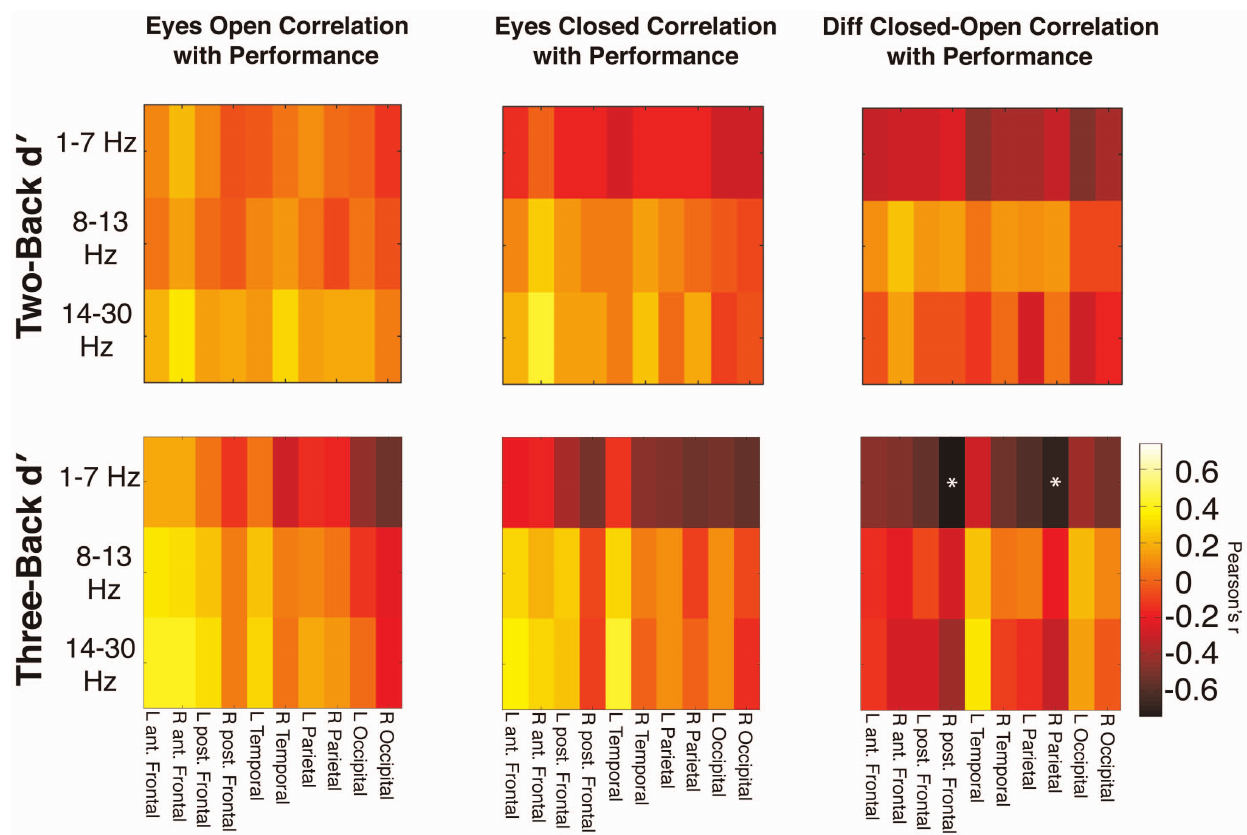
Figure 4. Pearson correlation coefficient (r) values between both two-back and three-back performance and normalized power in each region and band. The normalized difference between eyes closed and open power (zECO) revealed negative associations with two-back performance and left temporal and occipital power. Three-back performance was found to be inversely associated with delta/theta eyes open power in both the left and right occipital regions (1–7 Hz, R/L occipital). Eyes closed bilateral frontal and left temporal alpha and beta power were mildly positively associated with three-back working memory performance. The delta/theta band power in the bilateral occipital, bilateral parietal, right posterior frontal, and right temporal regions was most associated with three-back WM performance. The zECO power revealed negative associations with three-back performance in several delta/theta regions and significant correlations in the right posterior frontal and right parietal regions. *=Bonferroni corrected p , 0.05. (Fisher z corrected; 1–7 Hz, Open vs. zECO Bonferroni corrected